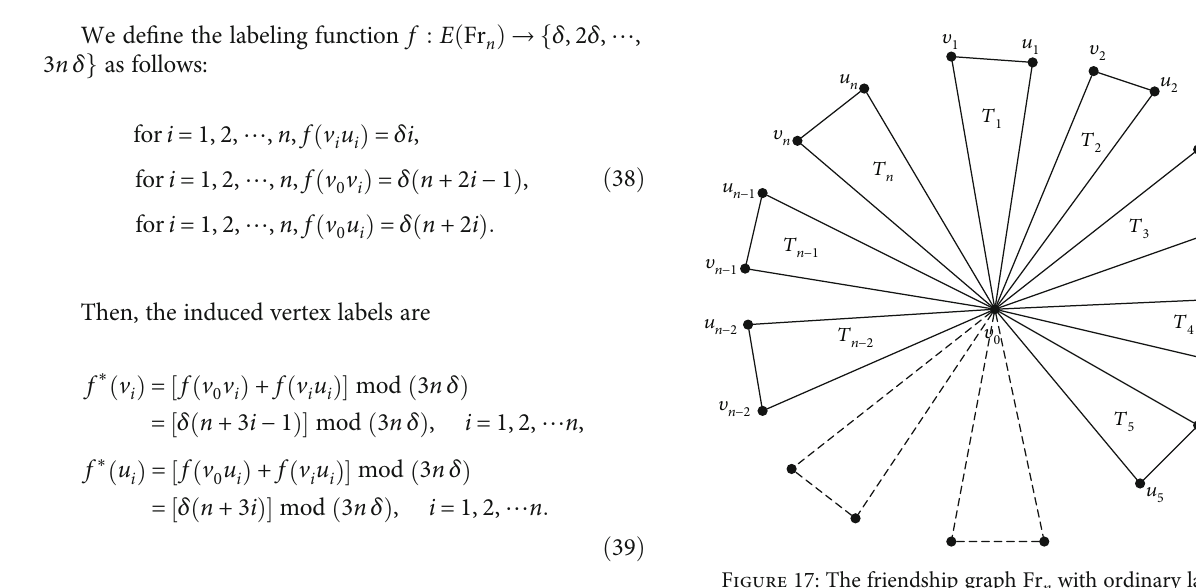
with ordinary n